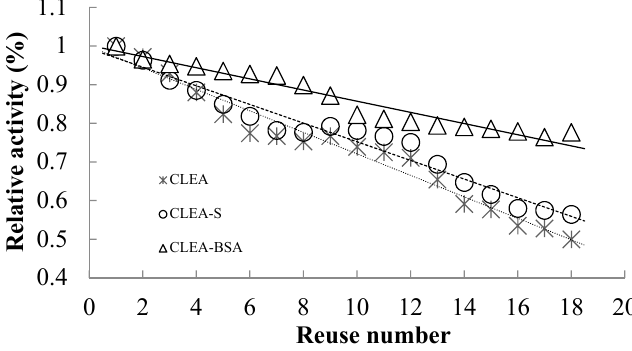
Figure 5. Recovery of immobilized enzymes. Assuming the initial enzyme activity was 100%.